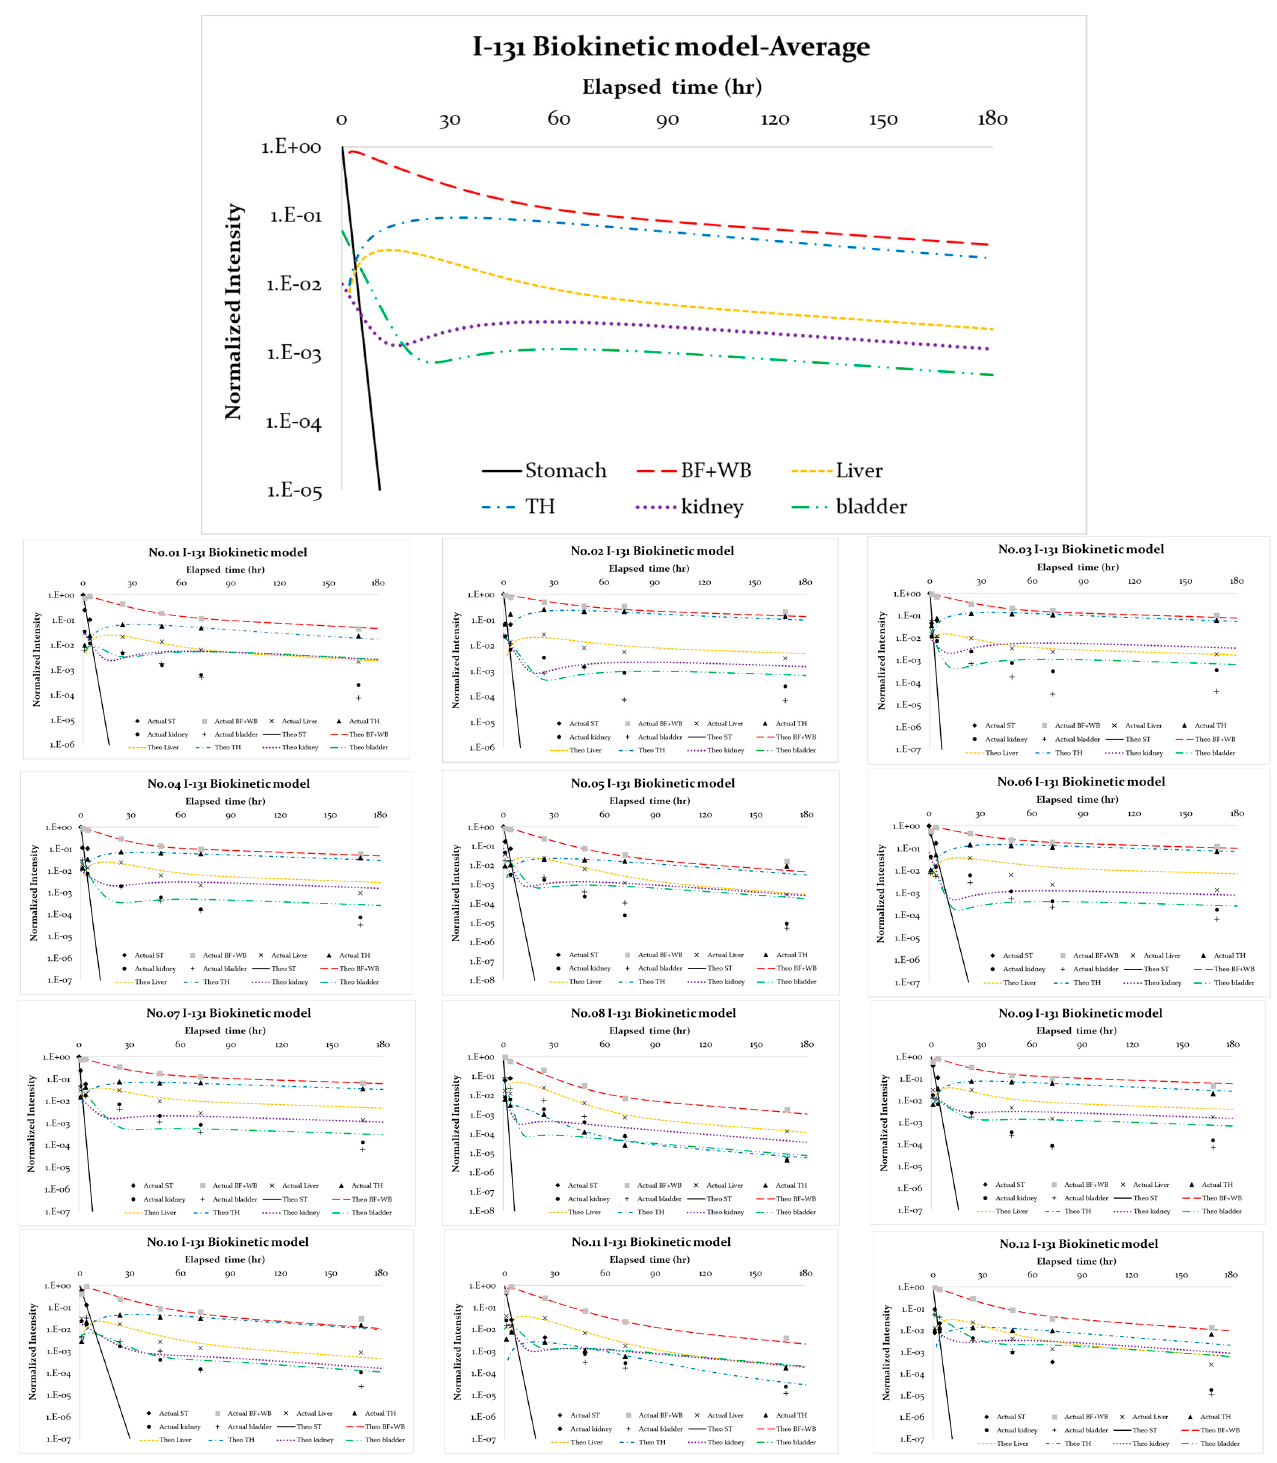
Figure 3. The normalized empirical data for patients and theoretical estimates via MATLAB. The former are illustrated by dots with error bars, and the optimal estimates are plotted with three continuous lines.